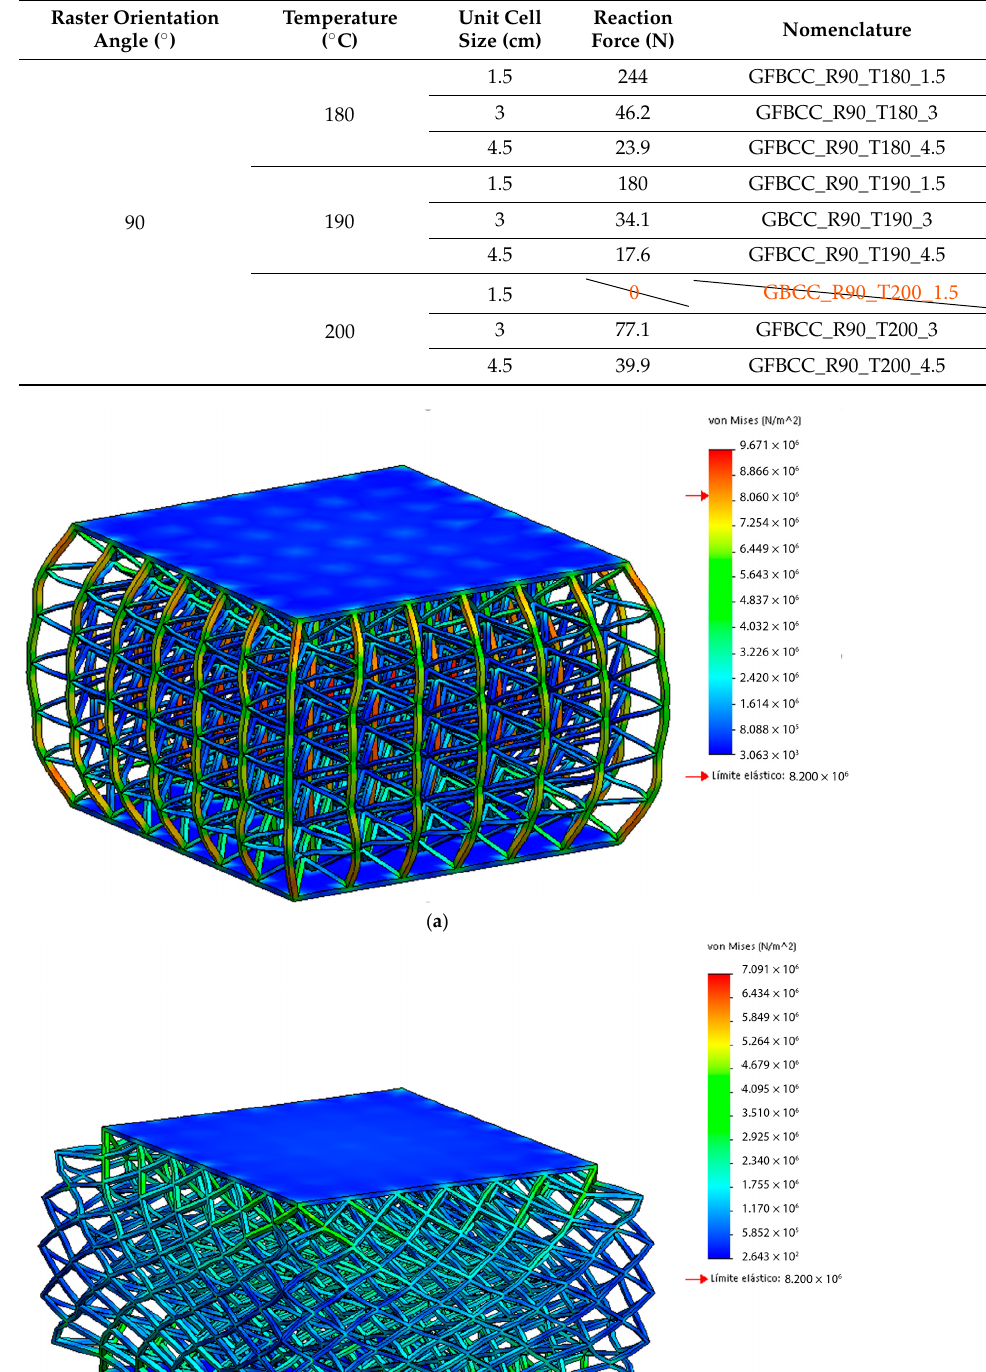
Figure A1. Example of unfavorable tests where the specimen does not support the compression loads (The sample presents tensions higher than the yield strength of the material). ( a ) Unfavorable test (Red Arrow on the stress bar indicates there are higher stresses values than yield strength of the material); ( b ) Favorable Test (There is not a red arrow on the stress bar).